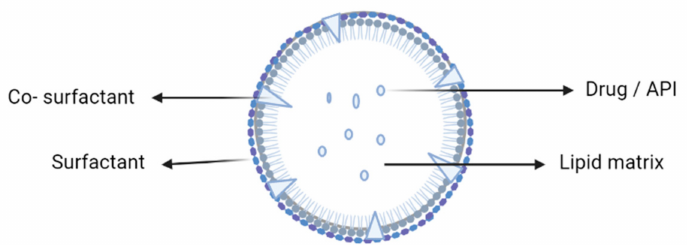
Figure 1. Structure of a solid lipid nanoparticle.